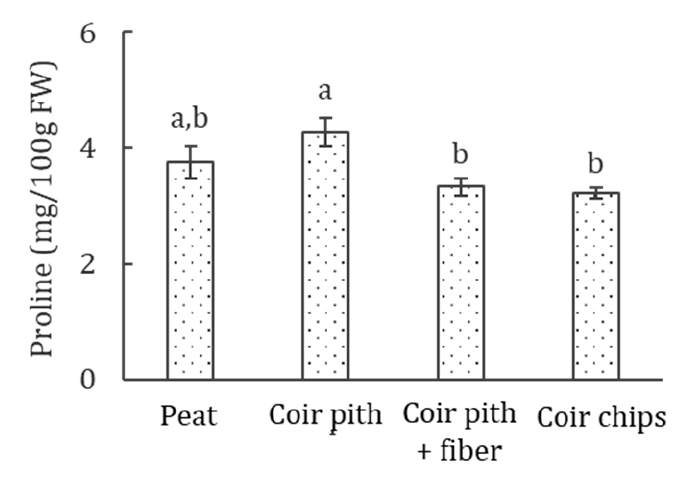
Figure 4. Proline content in the leaf blade. Means with different letters are significantly different at p < 0.05; FW—fresh weight. Each bar represents the mean of five replicates, and the error bars represent ± 1SE.